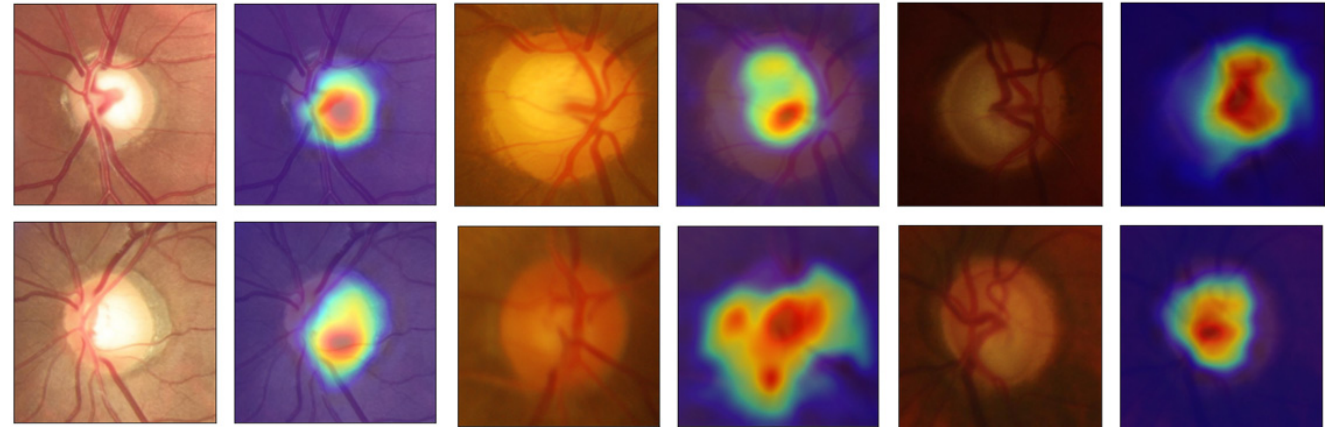
Figure 6. Activation maps of the classification models of the K-fold CV (left, original; right, heatmap). The importance is indicated by the emphasized shades in the following order, from the most important to the least important: red, orange, yellow, green and blue.